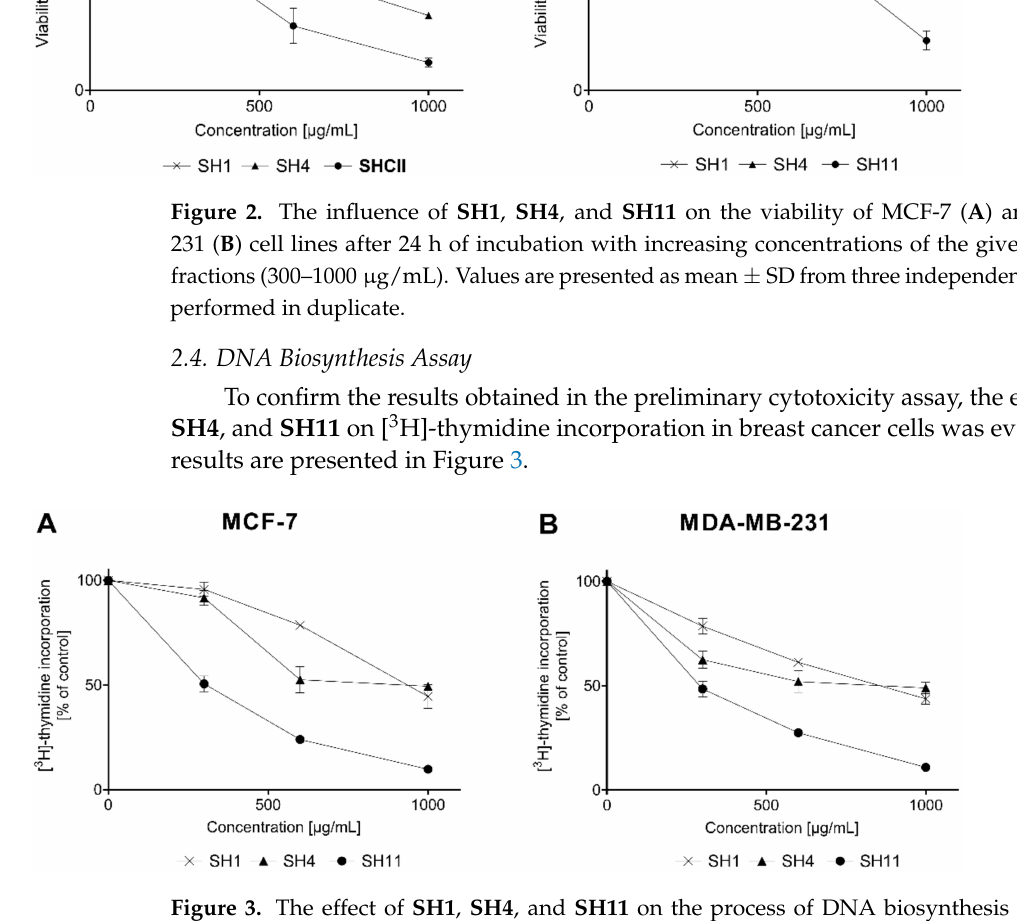
Figure 3. The effect of SH1 , SH4 , and SH11 on the process of DNA biosynthesis in MCF-7 ( A ) and MDA-MB-231 ( B ) cell lines after 24 h of incubation with increasing concentrations of the given extract and fractions (300–1000 µ g/mL). Values are presented as mean ± SD from three independent experiments performed in